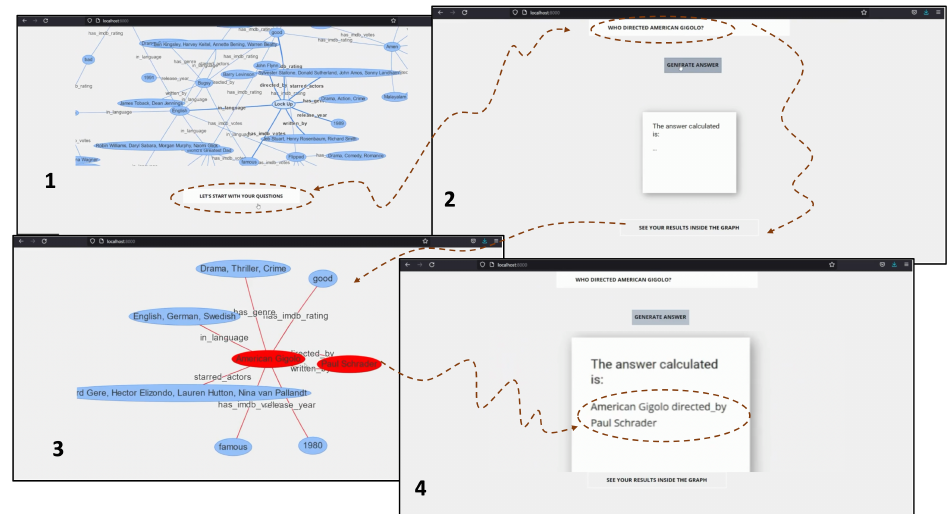
Figure 8. The system at work: initially, the user can submit a question (1) by clicking on Let’s start with your question on the web application GUI; then, the question Who directed “American Gigolò”? is submitted (2), and the corresponding graph is shown (along with the graph nodes colored) (3); finally, the answer is returned in the interface, as shown in